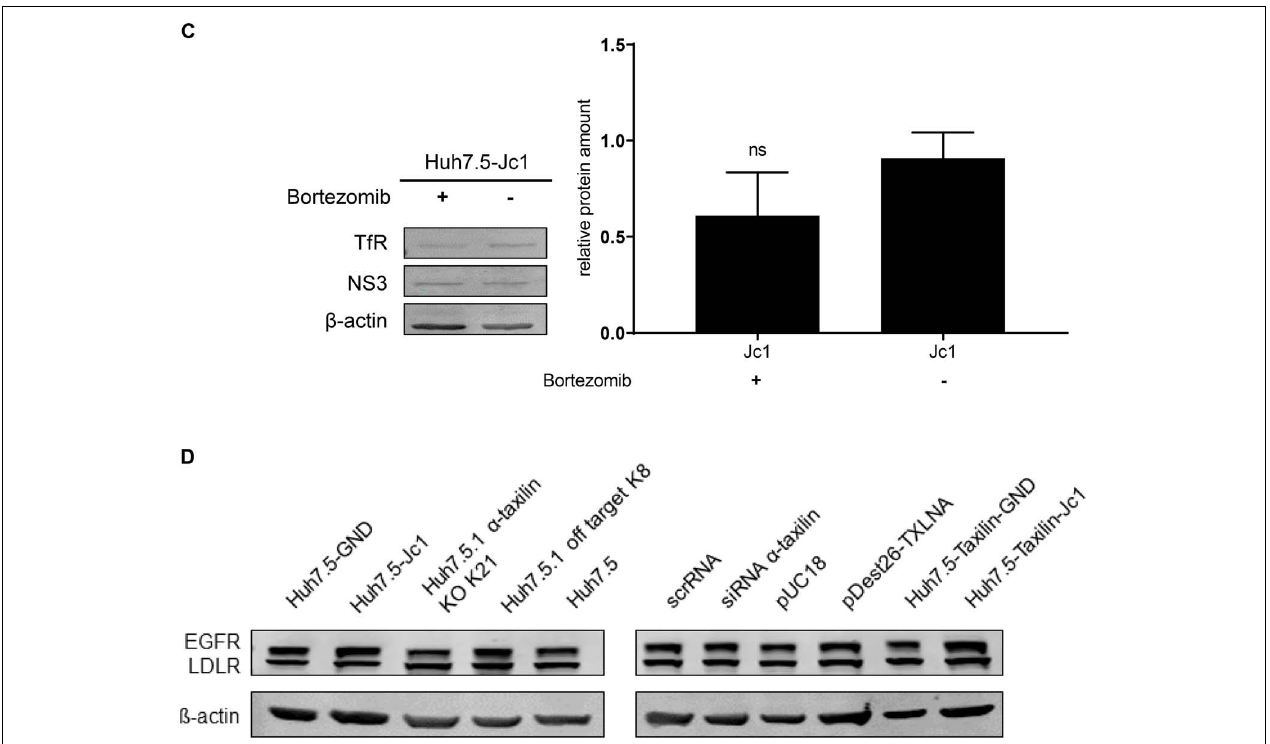
FIGURE 2 | The reduced amount of the TfR in HCV-positive cells is not due to a decreased expression. (A) (Top) Western blot analysis of cellular lysates derived from HCV-positive (Jc1) and HCV-negative cells (GND) Huh7.5 and stably α -taxilin overexpressing Huh7.5 cells (Huh7.5-Taxilin)72 hpe, treated with BFLA (50 nM) for 16 h. For detection, α - taxilin-, TfR-, and NS3-specific antibodies were used. ß-actin served as a loading control. (Bottom) Densitometric quantification of α -taxilin and the TfR from seven independent experiments. Untreated HCV-negative cells (GND) served as a control and were set as 1 ( n = 7; mean ± SEM). Two-tailed unpaired t -test, * p < 0.05, ** p < 0.01, **** p < 0.0001. (B) RT-qPCR analysis of TfR transcripts in HCV-positive (Jc1) and HCV-negative (GND) cells. HCV-negative cells served as a control and were set as 1 ( n = 3, mean ± SEM). The samples were normalized to RPL27 transcripts. Two-tailed unpaired t -test, ns = not significant. (C) Western blot analysis of cellular lysates derived from HCV-positive (Jc1) Huh7.5 cells 72 hpe, treated with Bortezomib (10 nM) for 16 h. For detectionTfR-, NS3-specific antibodies were used. ß-actin served as a loading control. Densitometric quantification of α -taxilin and the TfR from three technical